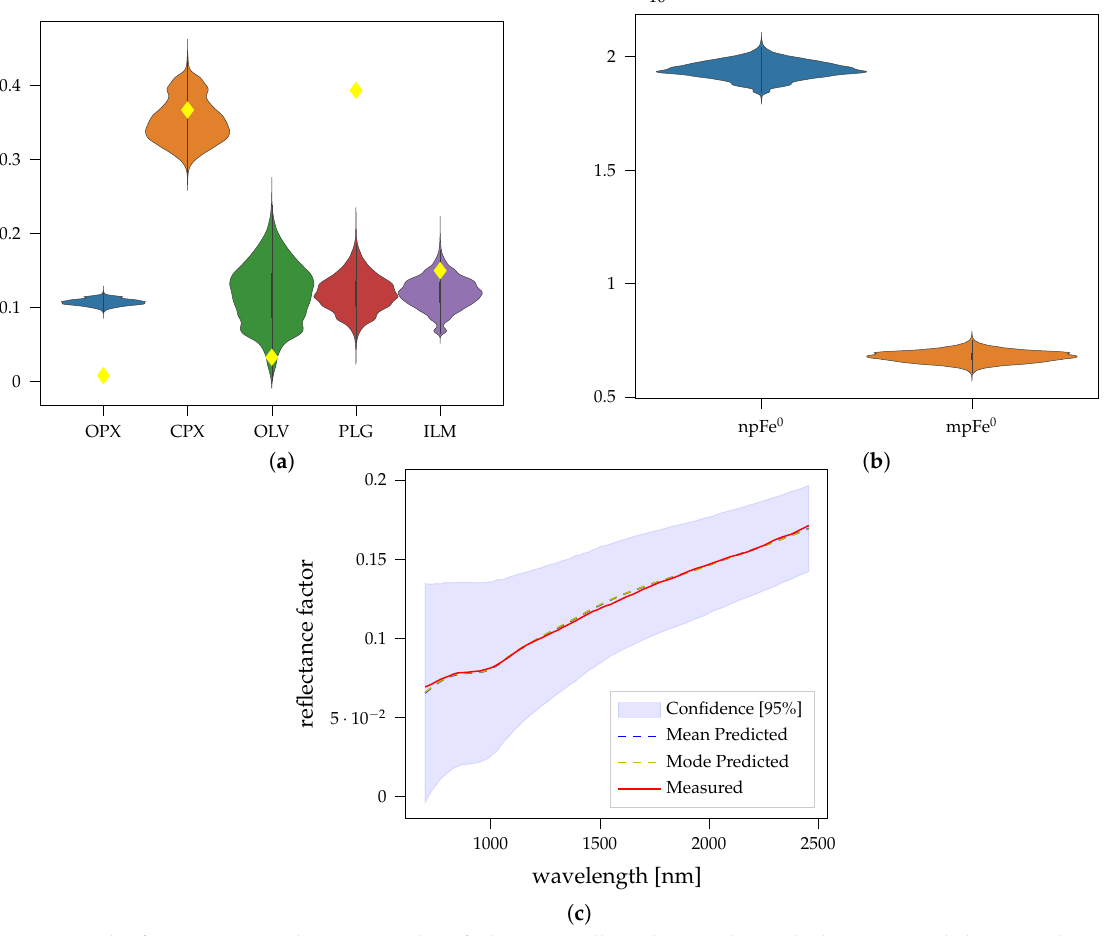
Figure 22. Results for LSCC sample 10084 with Ti/Al prior. Yellow diamonds mark the estimated theoretical mineral fractional abundances. Plagioclase is underestimated, while olivine is generally overestimated. This is a mature spectrum with an I s /FeO value of 88, therefore, also the estimated npFe 0 and mpFe 0 abundance is high. The spectrum is generally very dark. ( a ) Endmember abundances (10084); ( b ) smFe abundances (10084); ( c ) Confidence plot